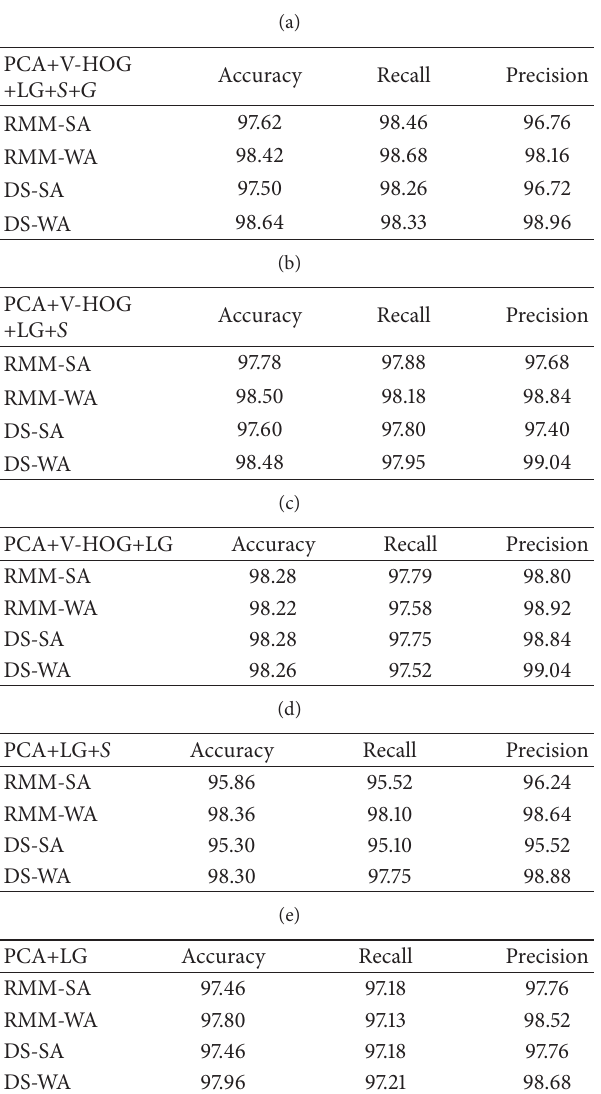
Table 10: Diversity measures for the left region: (a) Double Fault and (b) correlation